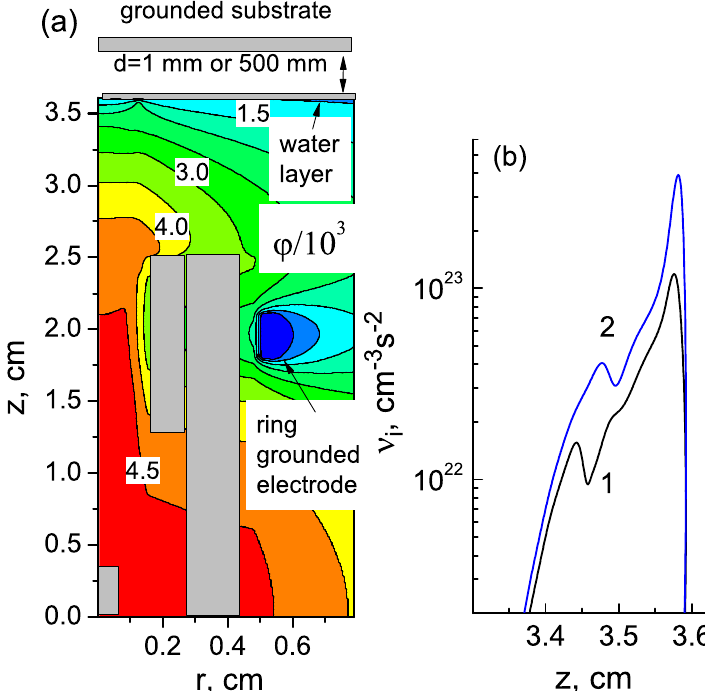
Figure 8. ( a ) Spatial distributions of electric potential at the moment when the streamer touches the target. Color palette is for 0–5000 V with the 500 V increment. ( b ) Ionization rate profile over z for the cases without the GR substrate (1) and with it (2), argon, U = 4.9